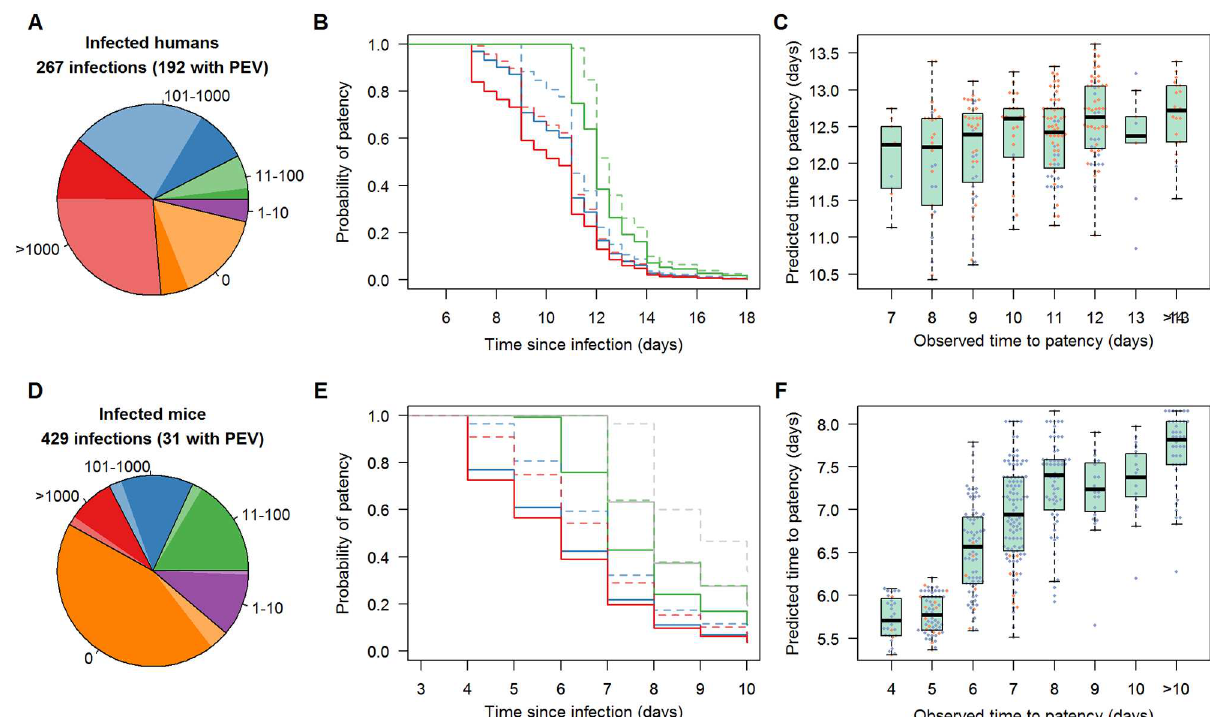
Fig 2. The association between the number of salivarygland sporozoites and the duration of the pre-patent period in humans (A, B,C) and mice (D,E,F). In panelsA,B,D,E unvaccinated/untreated control infectionsare denotedby a solid line (and darker shade of colour) whilst humans given a pre-erythrocytic vaccine (PEV) candidate or mice given an anti-circumsporozoite protein antibody(PEV) are shown by a dashed line (lighter shade of colour). Panels (A) and (D) show the numberof sporozoites in the salivary glands followingblood-feeding used in the different experimental infections. Panels(B) and (E) show the survival curves predictedby the model for the time between sporozoiteinoculation and patent parasitaemia. Grey, green, blue and red lines shows predictions for a vertebrate host with 5 bites from mosquitoes with 1–10, 11–100,101–1000 and > 1000 salivary gland sporozoites after blood-feeding, respectively(grey line is omitted from B as no human volunteers receivedbites solely from mosquitoes with 1–10 residual-sporozoites). Panels (C) and (F) show the ability of the best fit model to predict the time to patency for humans and mice. Each point gives the predictionfor an individualvolunteeraccordingto the residual-sporozoitescore of biting mosquitoesand whether they receiveda PEV (orangedots) or were untreated(blue dots).